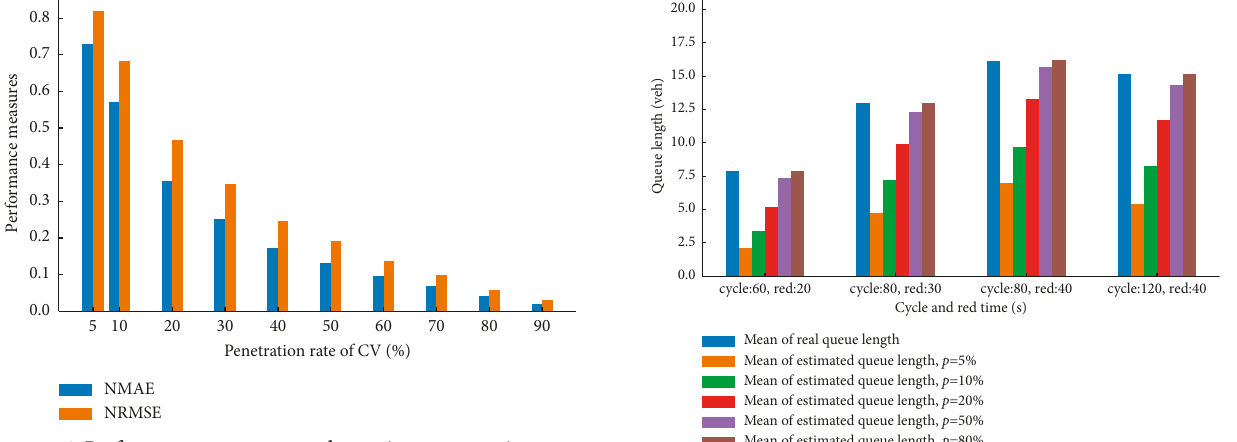
Figure 6: Performance measures under various penetration rates.